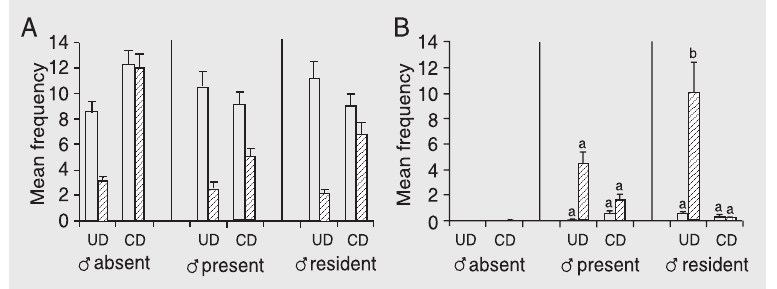
Figure 2. Frequency of behaviors indicative of dominant (A, N = 8) and submissive (B, N = 4) behaviors in Callithrix jacchus female pairs in uncontested dominance (UD) and contested dominance (CD) groups during each of the three 5-week study periods (period 1 - male absent; period 2 - male present; period 3 - male resident). Data are reported as means ± SEM. The straight lines indicate the end of a 5-week period and the beginning of the next. Open columns indicate dominant females and shaded columns subordinate females. Differ- ent letters above the columns represent statistically significant differences (P < 0.05, Tukey